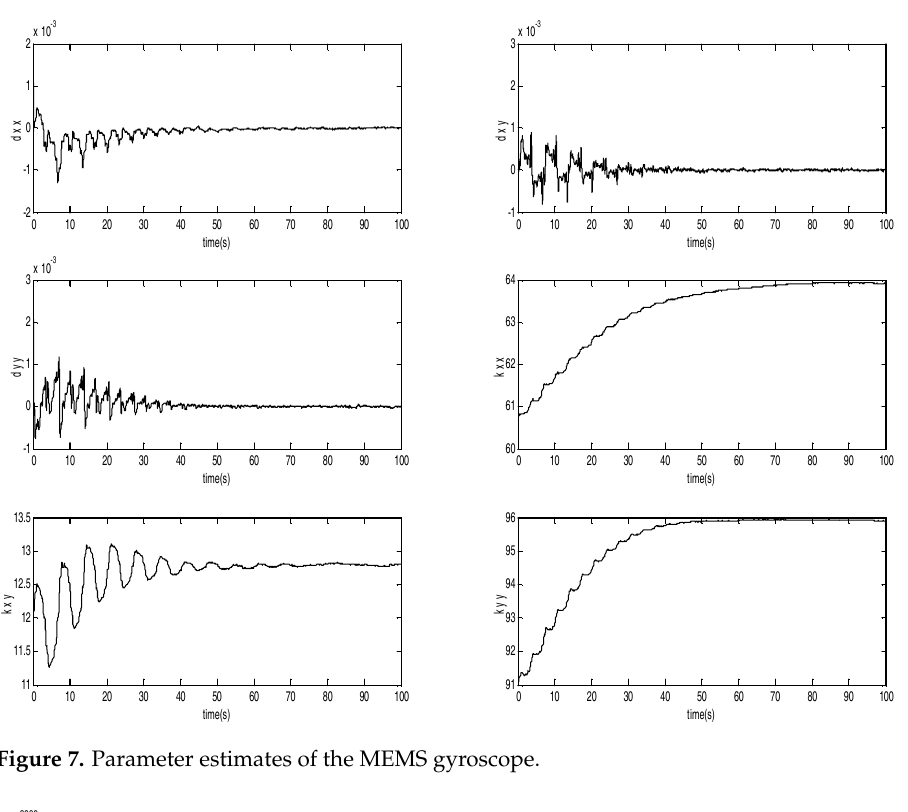
Figure 7. Parameter estimates of the MEMS gyroscope.